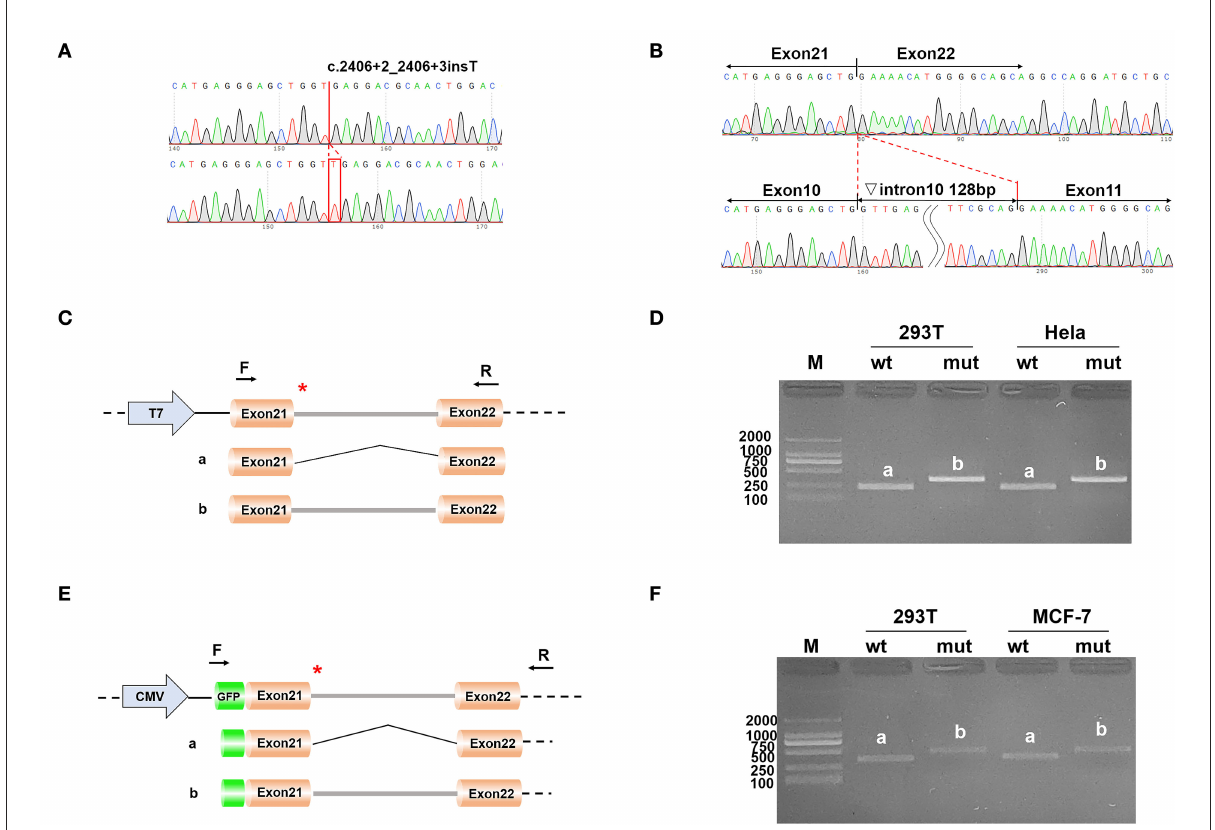
FIGURE2 (A) The result of the selected clones by sequencing; (B) The result of final expressed products of cells by sequencing; (C) Construction strategy of pcDNA3.1 vectors; (D) Electrophoretic results of expression products of pcDNA3.1 vectors in cell lines; (E) Construction strategy of pEGFP-C1 vectors; and (F) Electrophoretic results of expression products of pEGFP-C1 vectors in cell